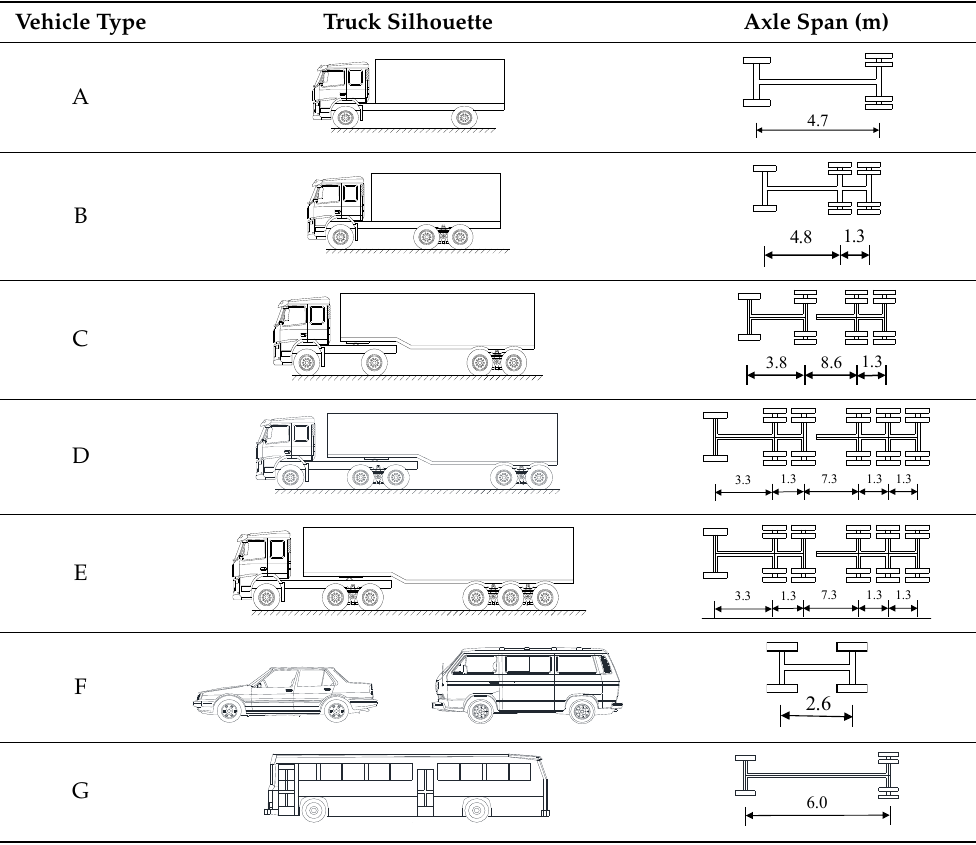
Table 2. Typical vehicle types of the investigated cable-stayed bridge.